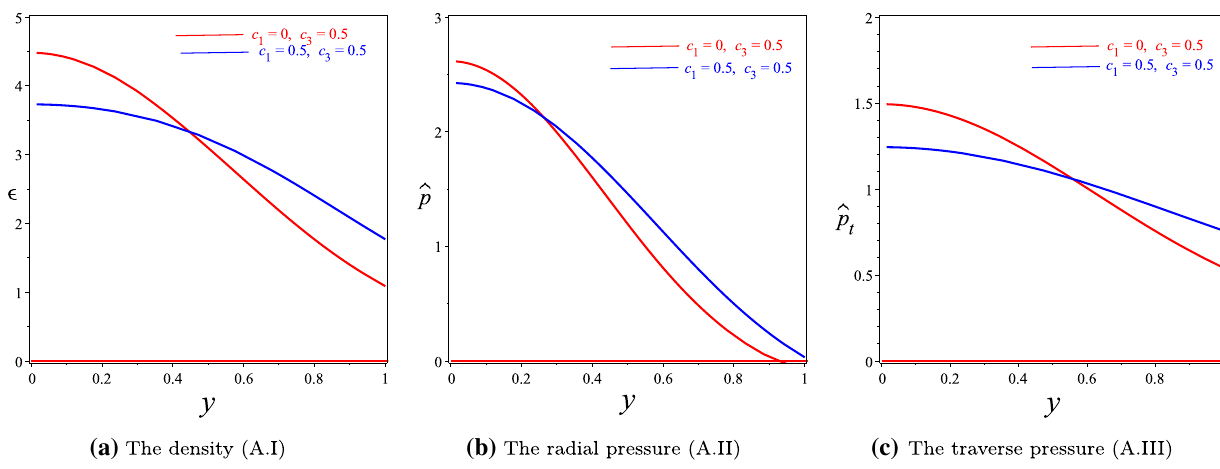
Fig. 1 Density, radial and transverse pressures when c 1 = 0 and c 1 = 0 .